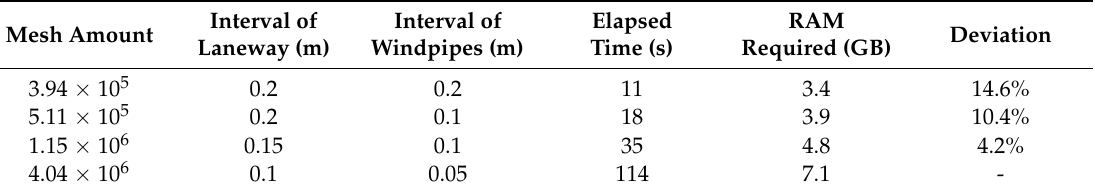
Table 1. Details for the mesh generation of computational